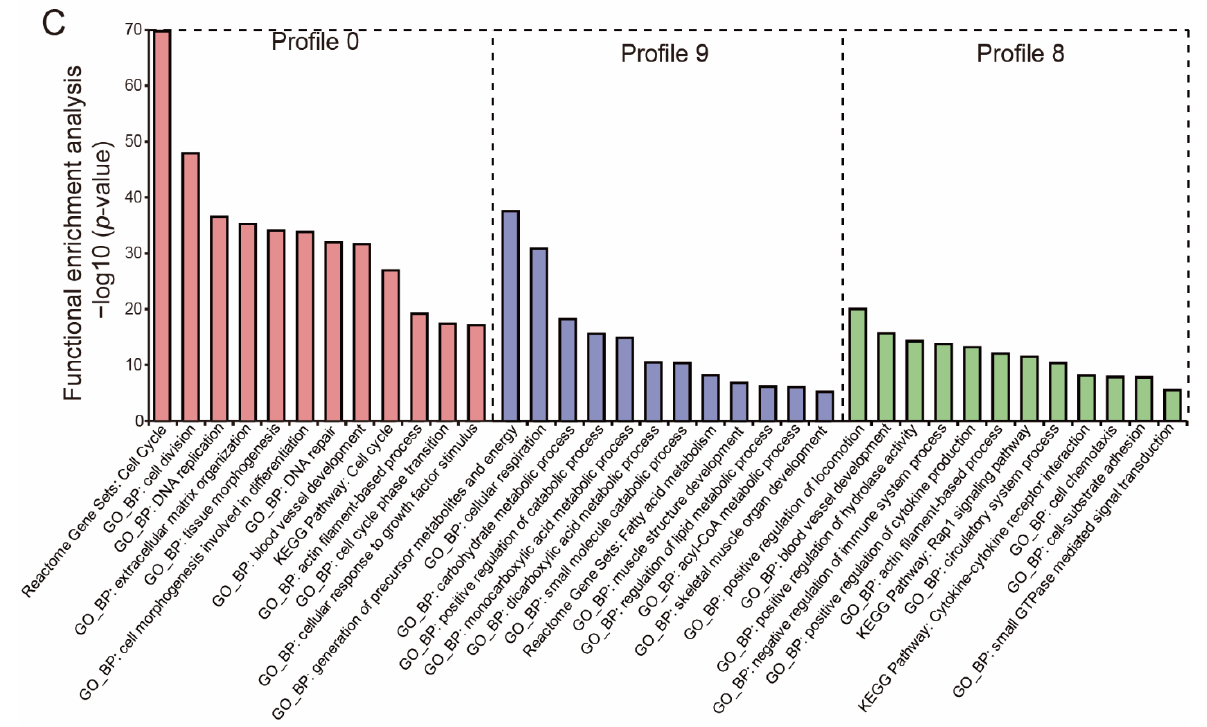
Figure 4. Time-course gene expression and functional enrichment analysis. ( A , B ) Time – series modules of DE-mRNAs ( A ) and DE-lncRNAs ( B ) are shown. The significantly enriched profiles are red, purple, and green colored ( p < 0.05). The numbers in the upper-left corner of each pane denote the profile number; the numbers in the middle of each pane denote the number of genes in each profile; the numbers in the lower-left corner of each pane denotes the p -value of each profile. ( C ) Functional enrichment analysis of DE-mRNAs corresponding to significant profiles.